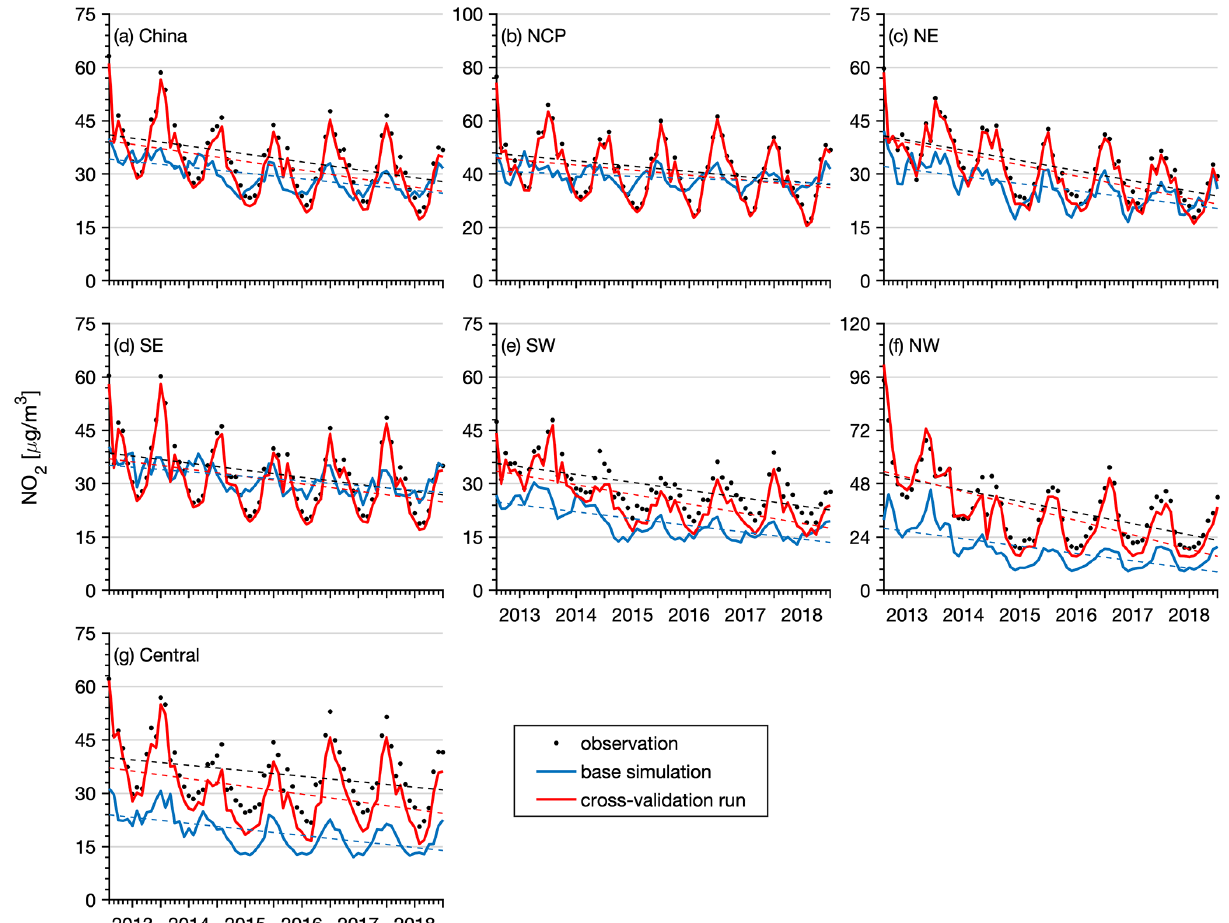
Figure 13. Same as Fig. 7 but for the CO